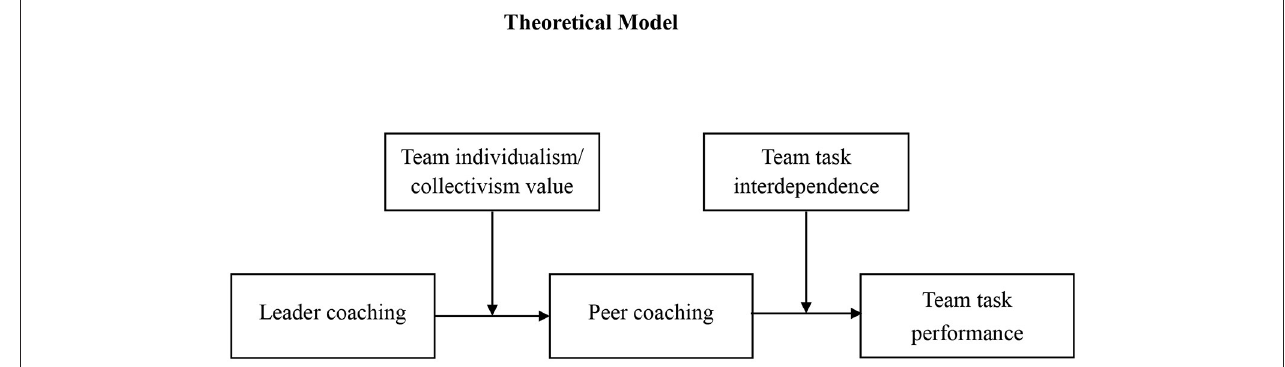
FIGURE 1 | Theoretical